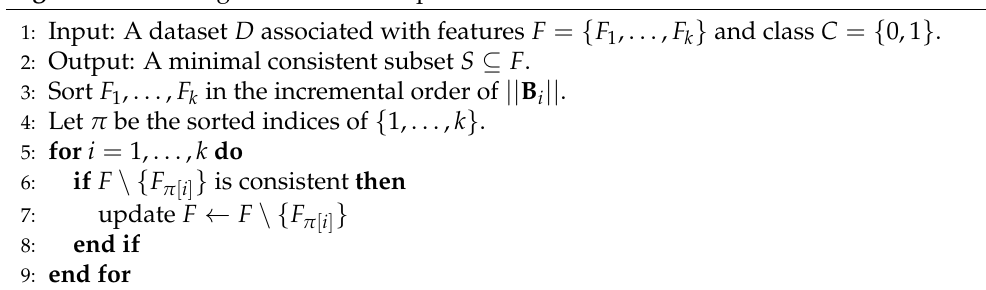
Algorithm 1 The algorithm CWC for plaintext